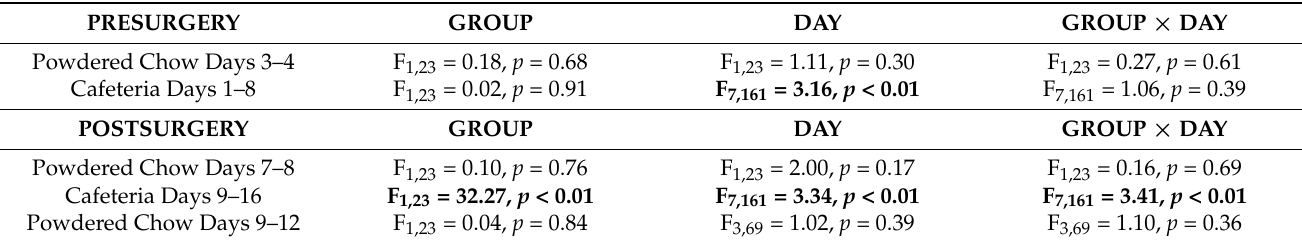
Table 10. Two-way ANOVAs Comparing 22-H Meal Eating Rate between Groups for Each Diet Condition.